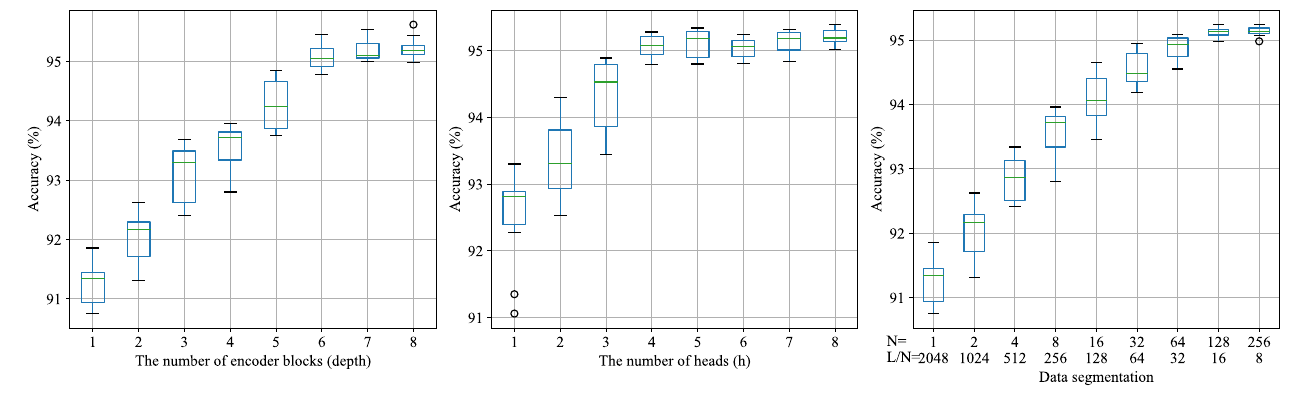
Figure 10. Box plot with different network structure parameters. Table 5. Influence of the VSF-ST structure